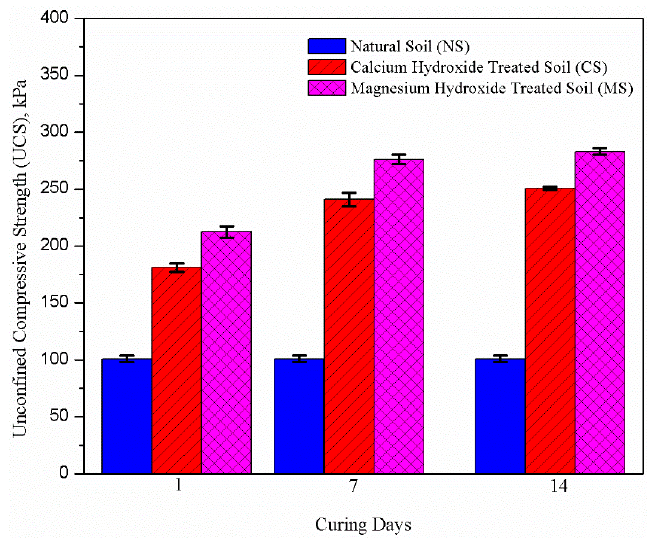
Figure 4. The unconfined compressive strength for untreated and nanoparticles-treated soil specimens subjected to one, seven, and 14 days of curing.